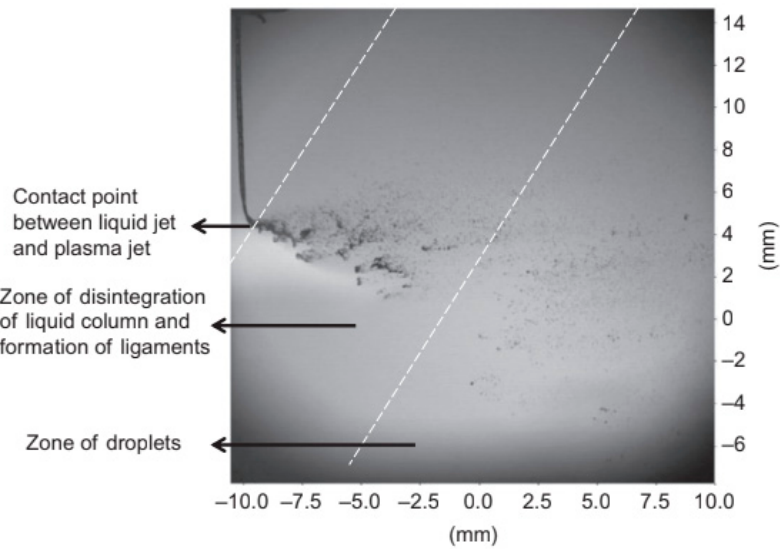
Figure 6. Aerodynamic interactions between the liquid stream and the high-temperature jet. Reproduced with permission from [32].